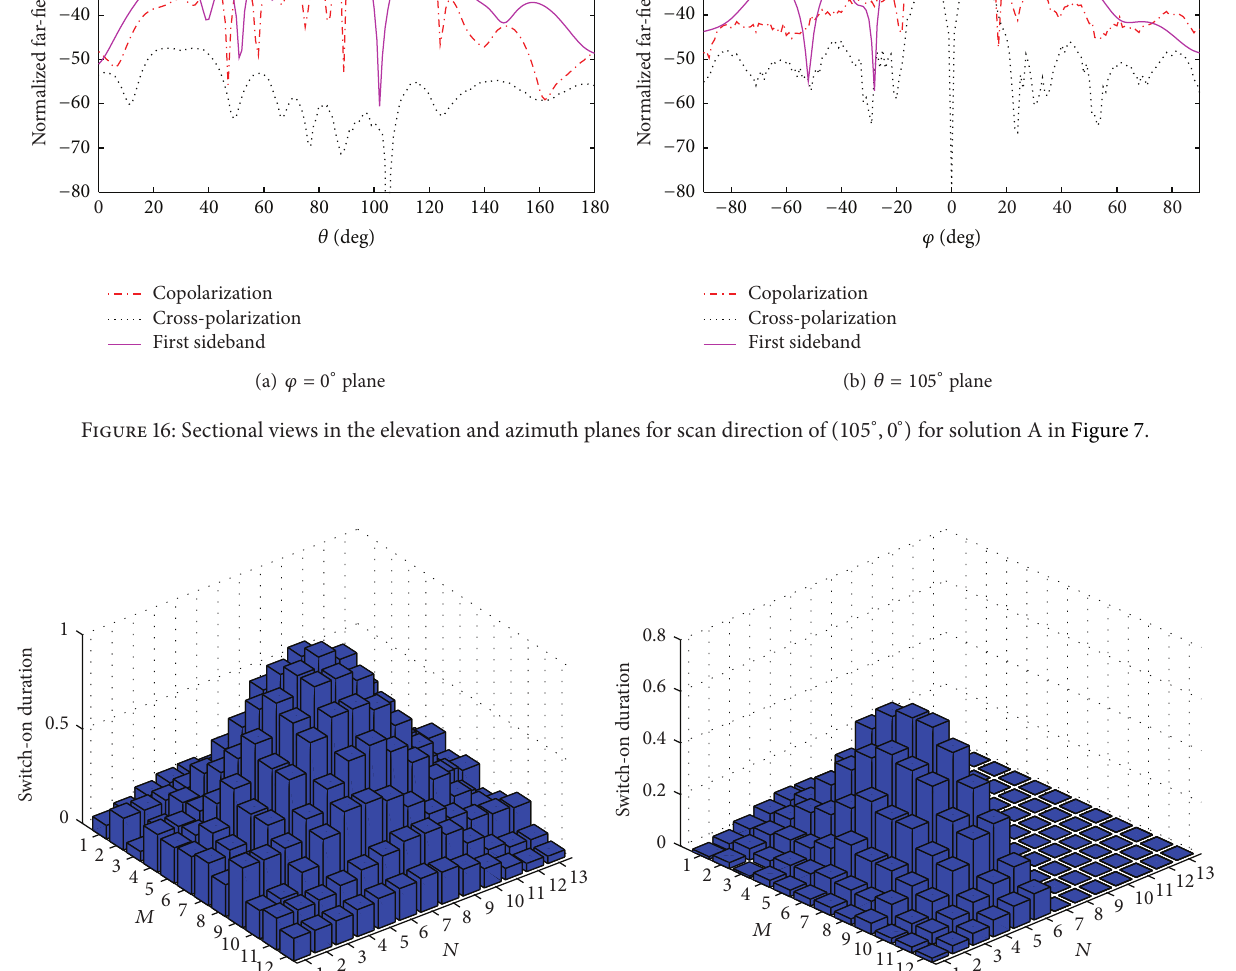
as the peak SLL and SBL have been optimized